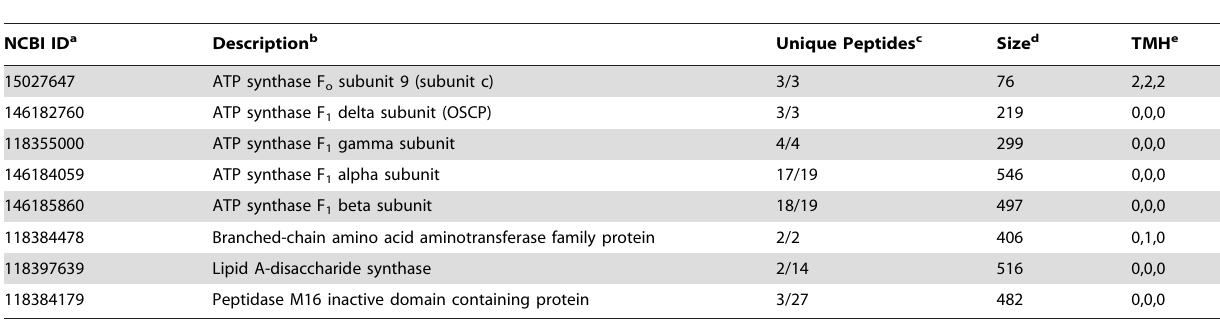
Table 1. Assigned proteins detected in BN-PAGE Spot 1 by LC/MS/MS.